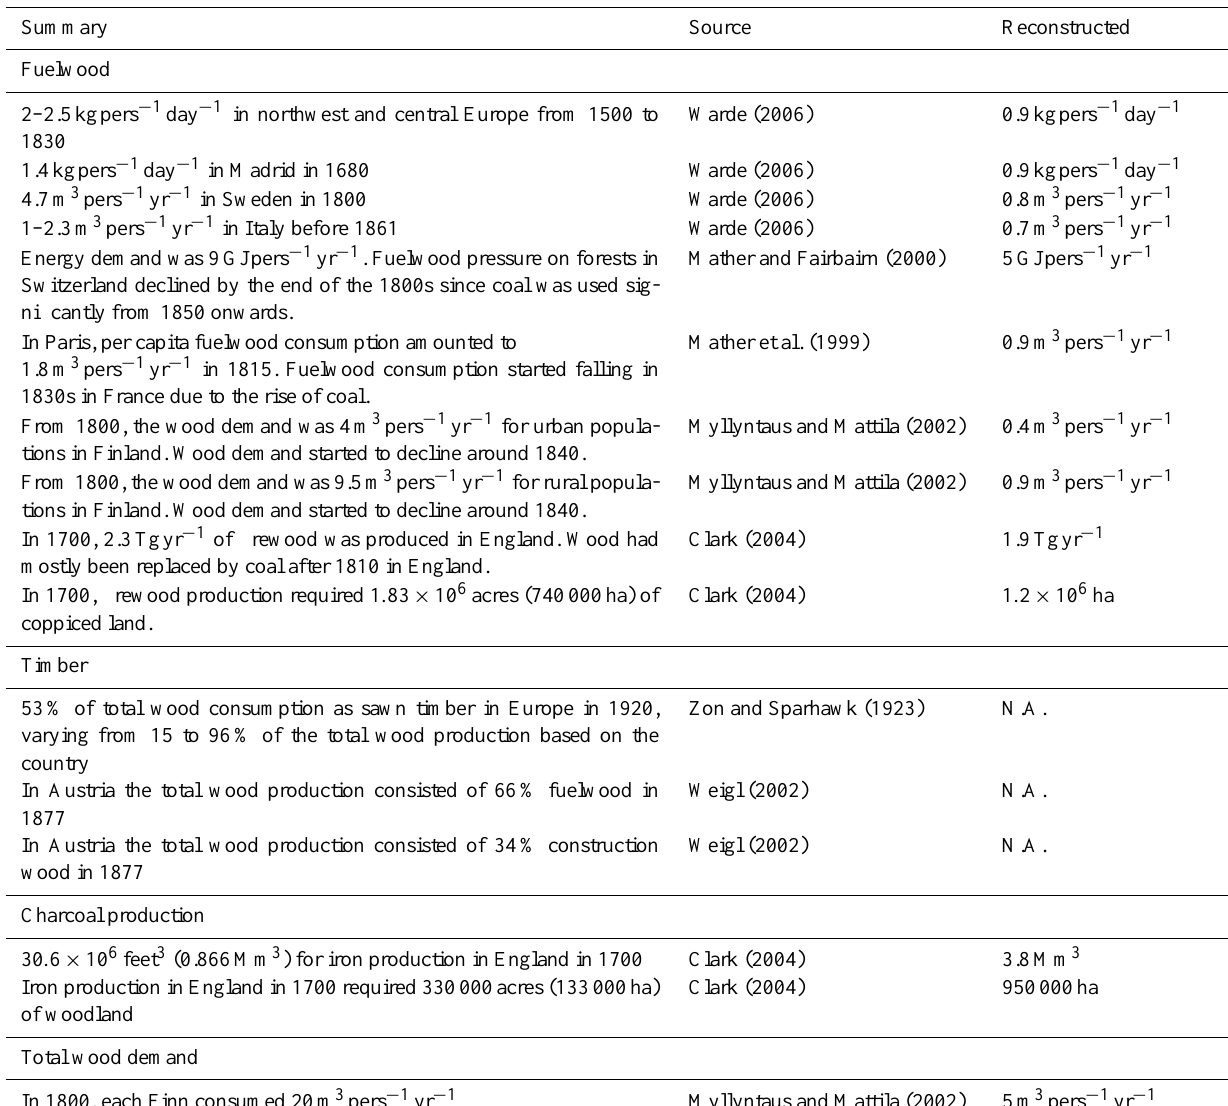
Table 3. Summary of independent information, i.e., information not used to create our estimates, for European wood demand from around 1600 to